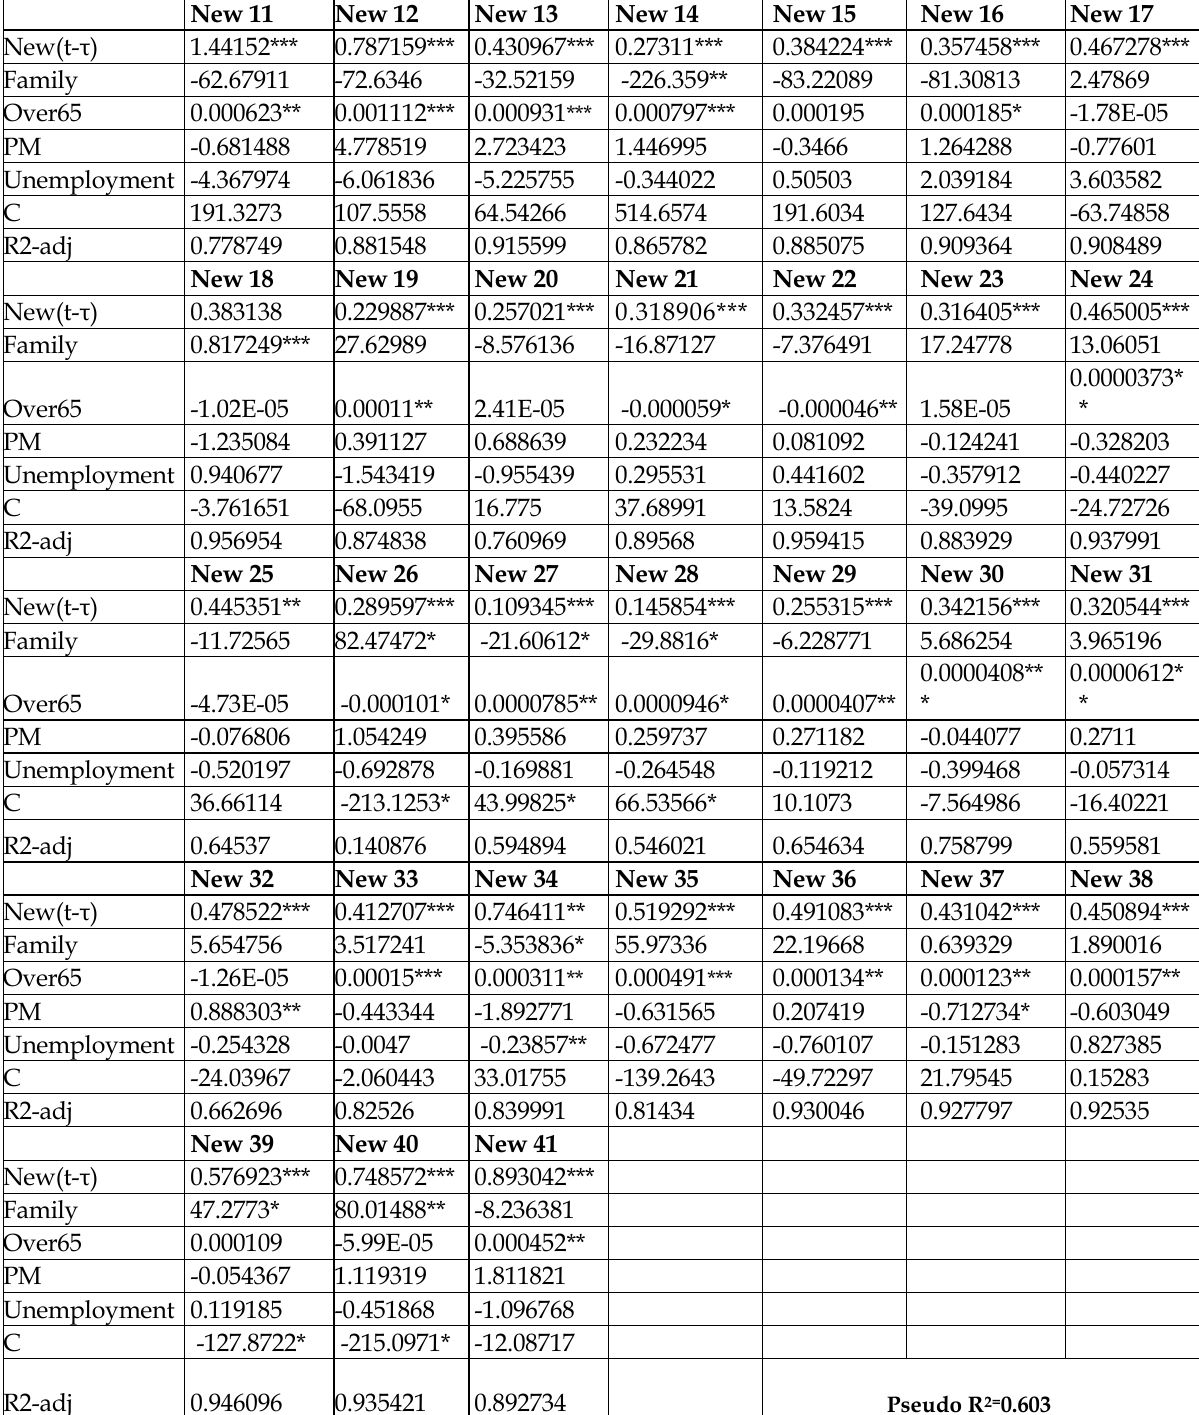
Parameters of base model, which include new cases and control variables by